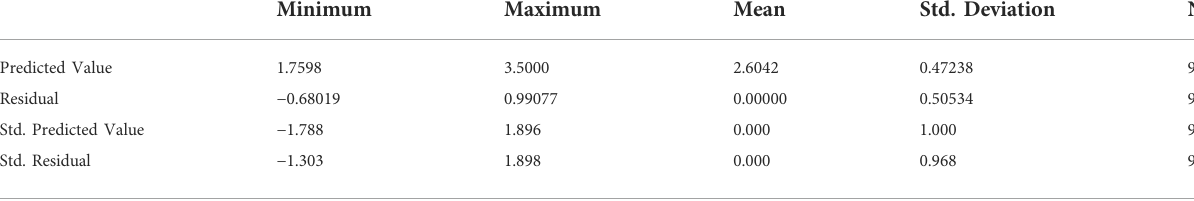
TABLE 15 Residuals statistics corresponding to the dependent variable for